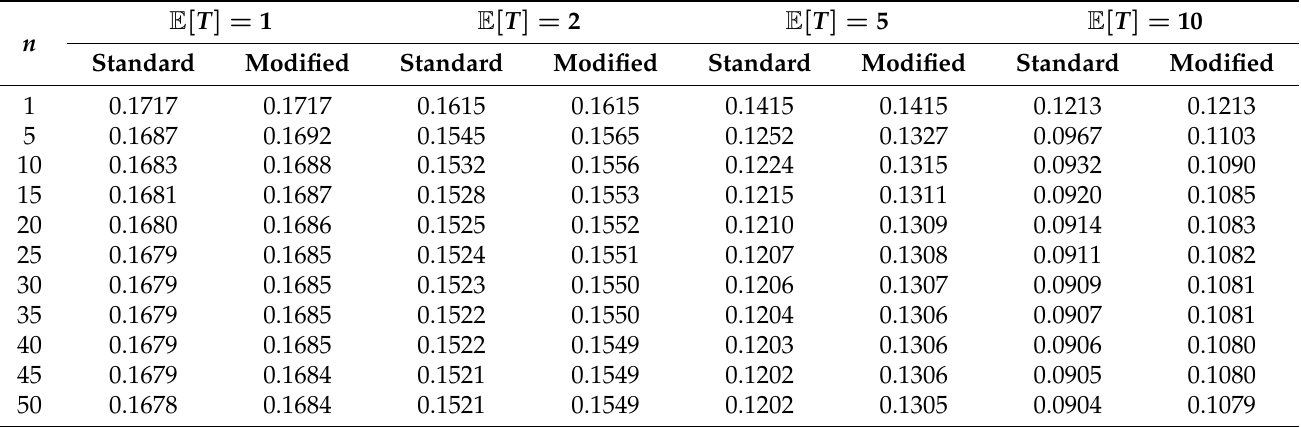
Table 2. Standard and modified Parisian ruin probabilities under exponential claims when u =